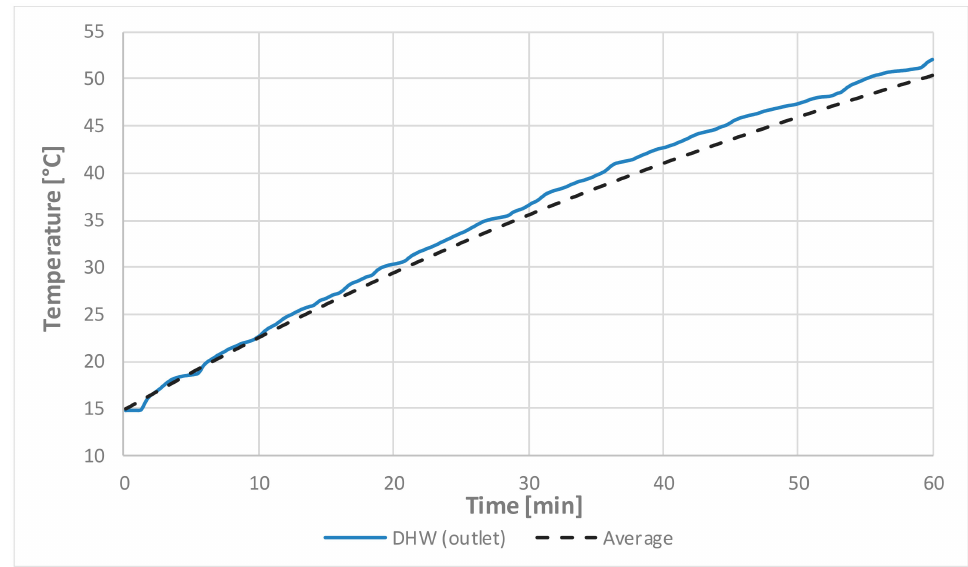
Figure 5. DHW outlet and tank average temperatures during the tank heating